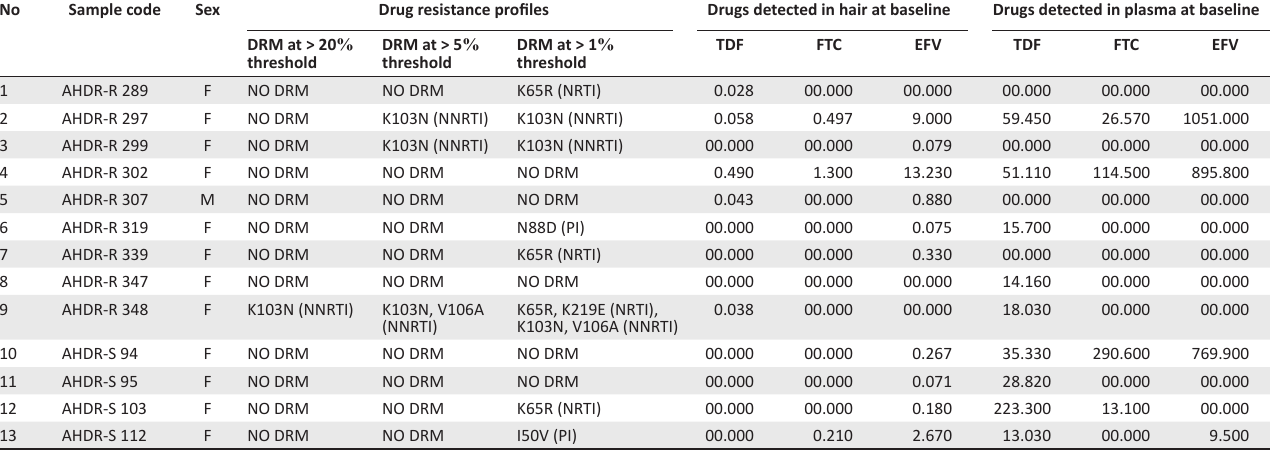
TABLE 3: Participants having at least one drug at baseline in either the hair or plasma matrix with their drug resistance profiles. No Sample